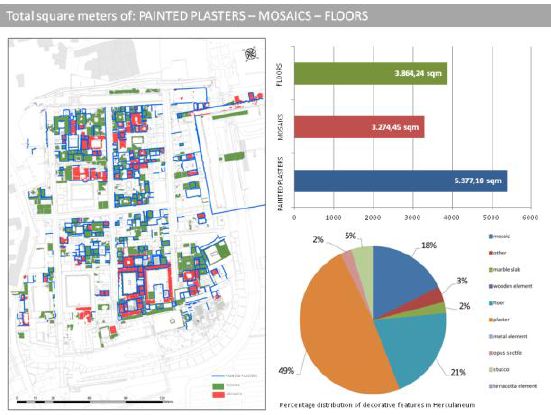
Figure 1: Distribution and quantities of main decorative features in